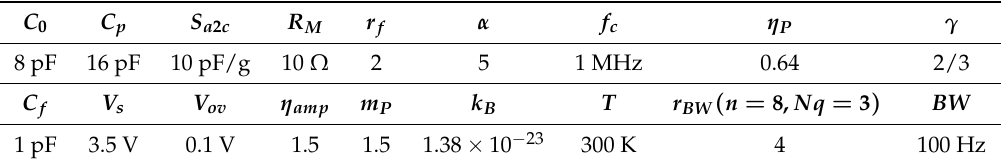
Table 1. The parameters used for numerical comparison.